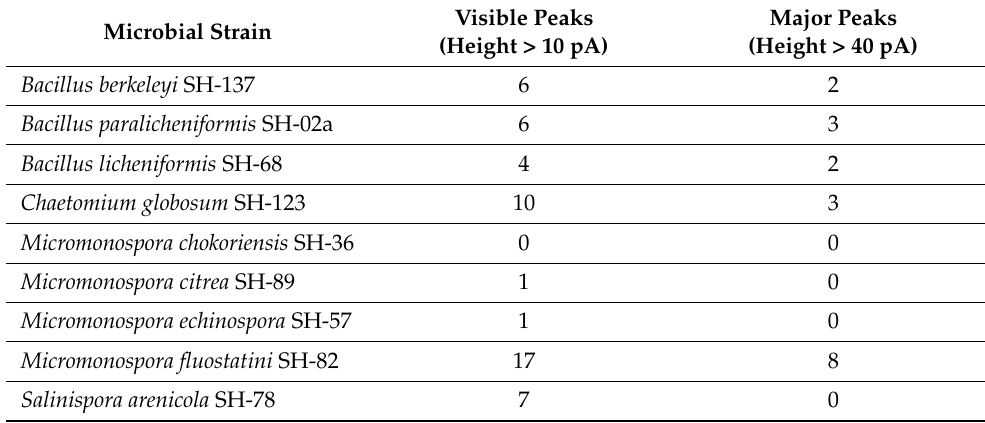
Table 2. Number of (visible and major) peaks observed for each microbial extract. Microbial Strain